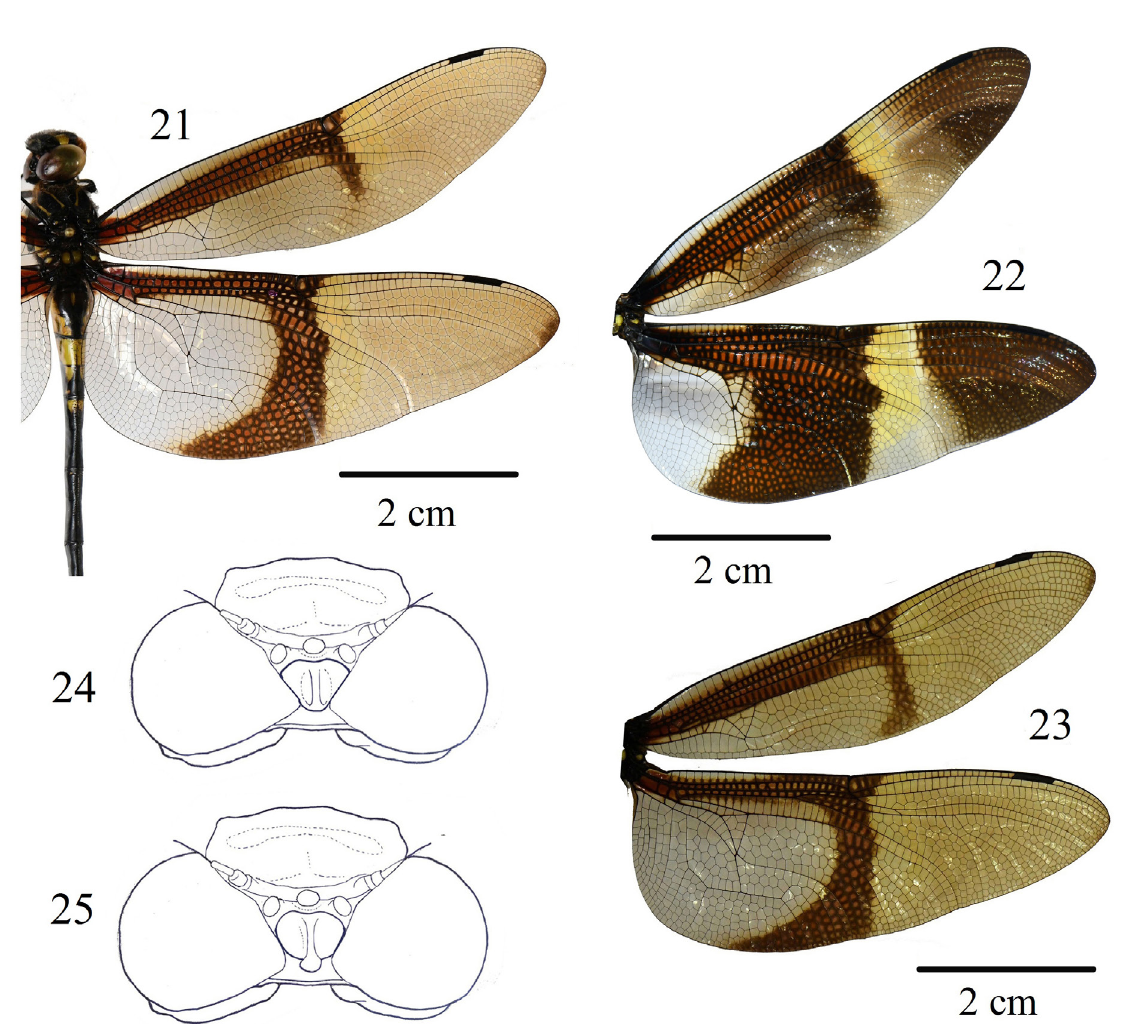
Figs 21–25. 21–23 . Right wings of species of Chlorogomphus Selys, 1854, ♀♀. 21 . C. hoaian sp. nov. (ZCDTU 2019042003-ODO). 22 . C. aritai Karube, 2013 ( ZCDTU 2021061901 ). 23 . C. caloptera Karube, 2013 (ZCDTU 2016042201-ODO). 24 . Head of C. hoaian sp. nov., holotype, ♂ (ZCDTU 2019042001-ODO). 25 . Head of C. hoaian sp. nov., paratype, ♀ (ZCDTU 2019042003-ODO). 24–25 not to